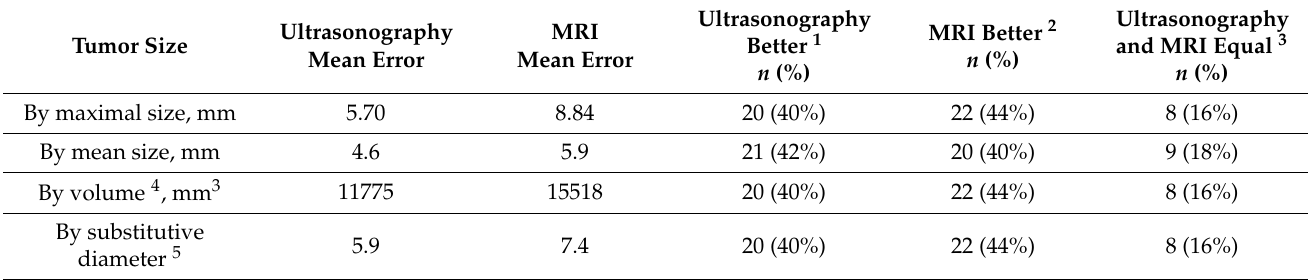
Table 6. Discordance between imaging (ultrasound and MRI) and histology for primary and residual tumor (after conization) measurements (additional data in Table